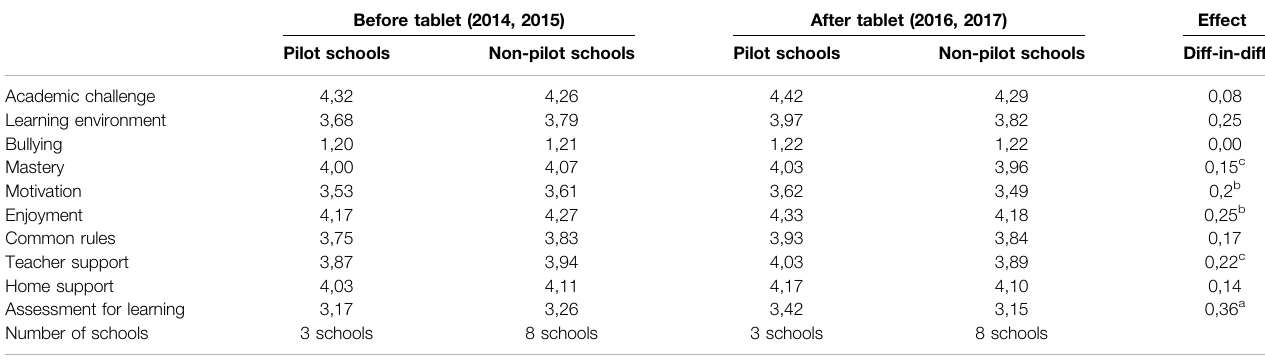
TABLE 13 | Difference-in-difference analysis of student survey indicators, 10th grade (group